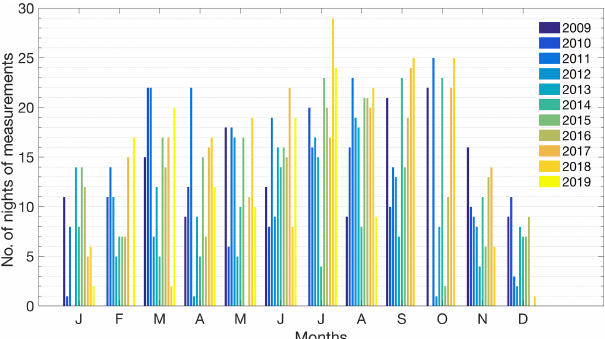
Figure 1. The total number of semi-clear nights with at least 30min of profiles per month from 2009 through the middle of August 2019. Winter months have fewer measurements due to more cloud cover and precipitation. Most measurements are taken in the